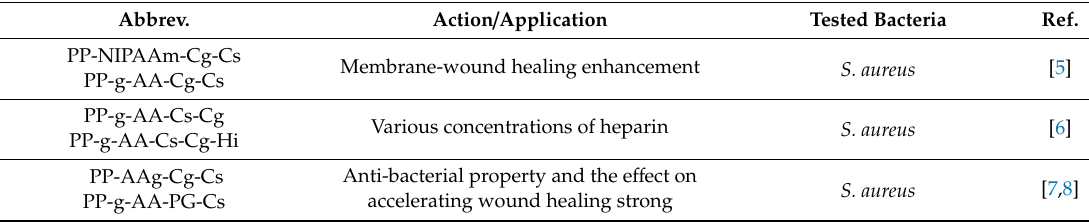
Table 1. Antibacterial polypropylene